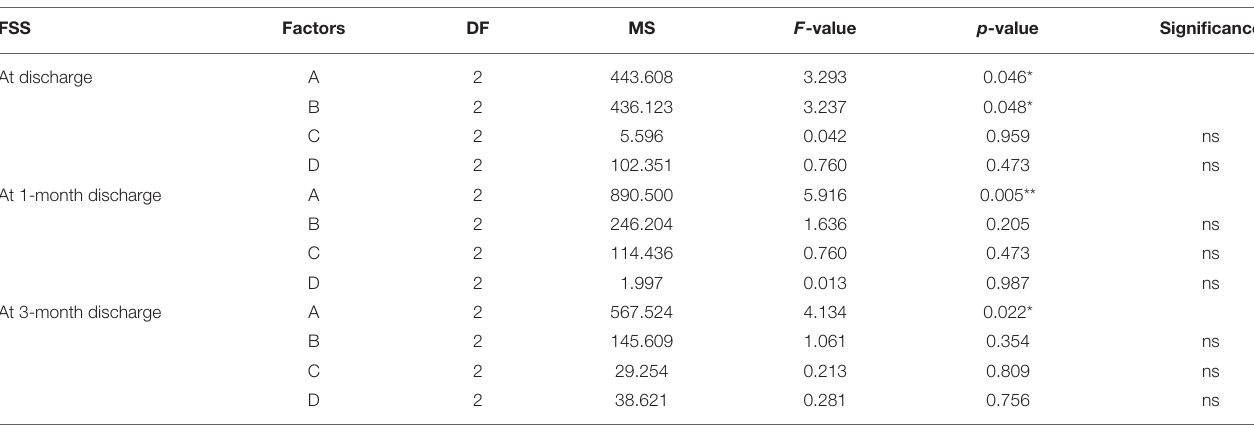
TABLE 7 | ANOVA of the factors affecting the severity of fatigue.